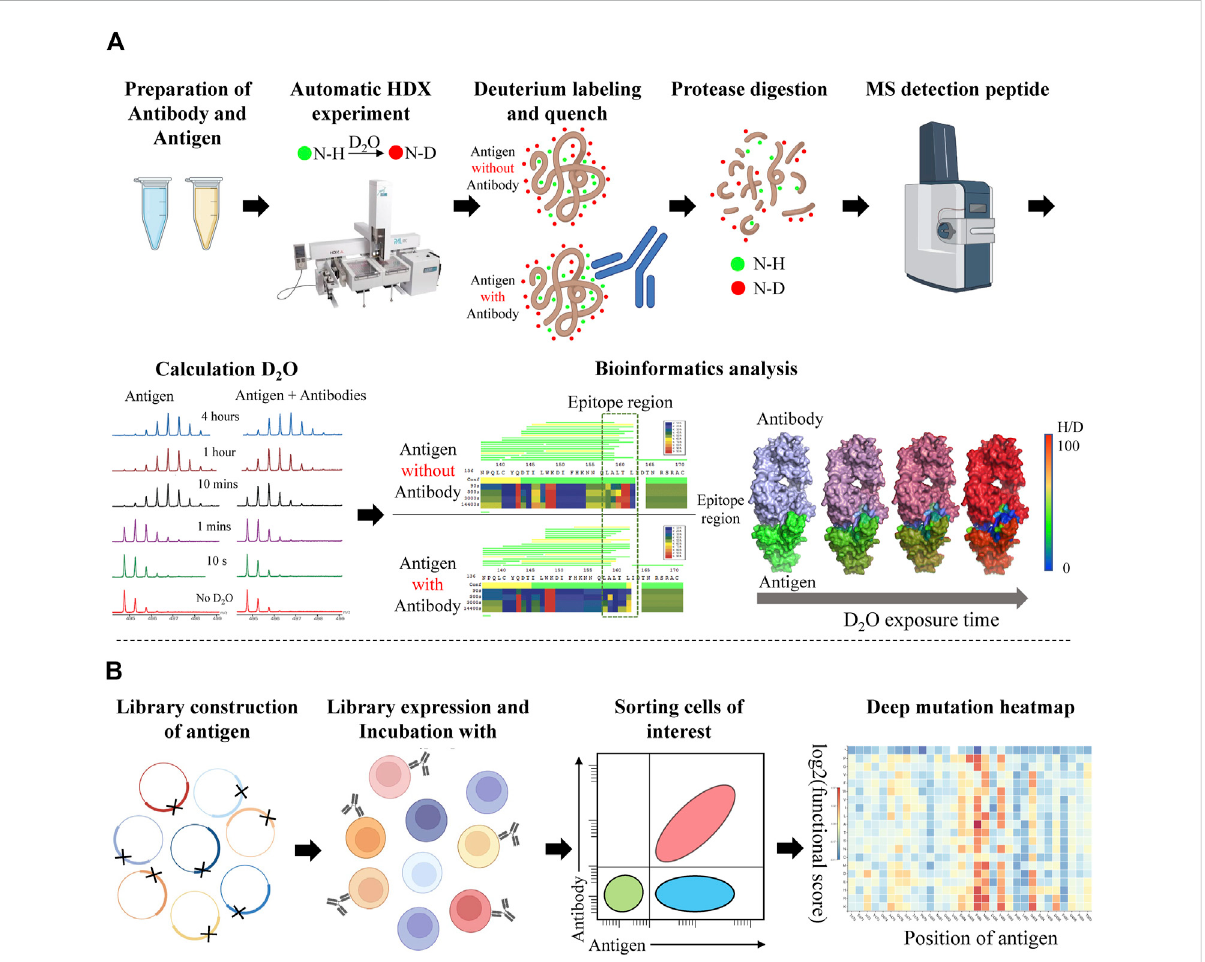
FIGURE 5 Work fl owofHydrogen-DeuteriumExchangeMassSpectrometry(HDX-MS)and Deepmutationalscanning (DMS)for epitope mapping. (A) The HDX-MS work fl ow consists of high-quality protein sample preparation; antigen HDX experiment with or without the presence antibody; antigen peptides are processed by MS; levels of deuteration are quanti fi ed by intensity-weighted centroid m/z value; epitope mapping. (B) The DMS work fl ow consists of library construction of antigen mutants; expression; coincubation with antibody; cell sorting; sequencing; visualization of results as a